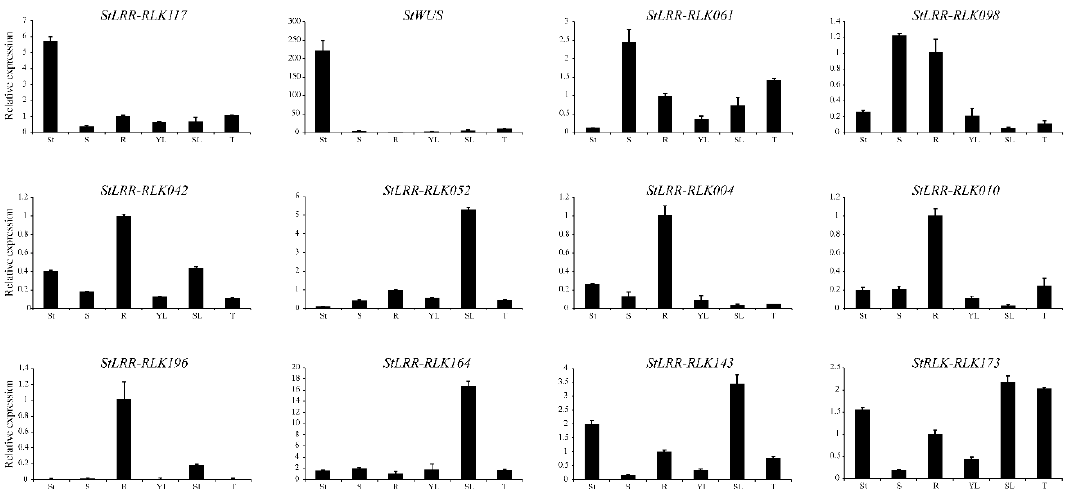
Figure 7. Transcriptional level of selected StLRR-RLK genes in various tissues by qRT-PCR. To reveal the tissue specificity, the expression level of the genes was represented as folds relative to the expression level of root. These qRT-PCR data presented here were obtained from three independent biological replicates with three technical repeats. St, shoot tip; S, stem; R, root; YL, young leaf; SL, senescence leaf; T, tuber.